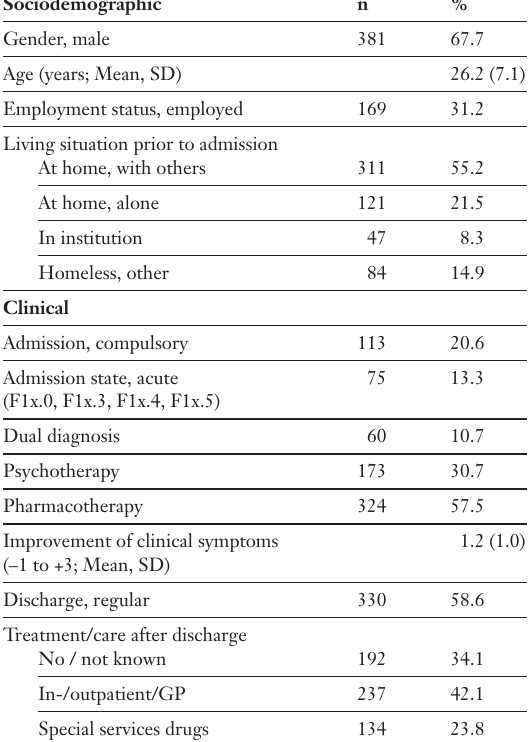
Table 2 Patients admitted for SUD: sample characteristics (n = 563)